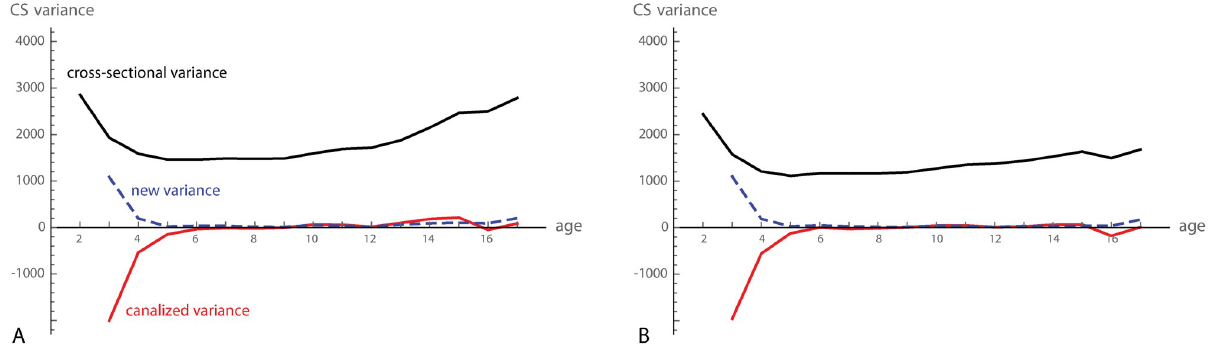
Fig 4. Canalized variance of craniofacial size. (A) Cross-sectional variance (black curve), canalized variance (red curve), and newly added variance for cranial centroid size (CS). (B) Same as in A, but here average sexual dimorphism was removed from the data prior to the analysis.